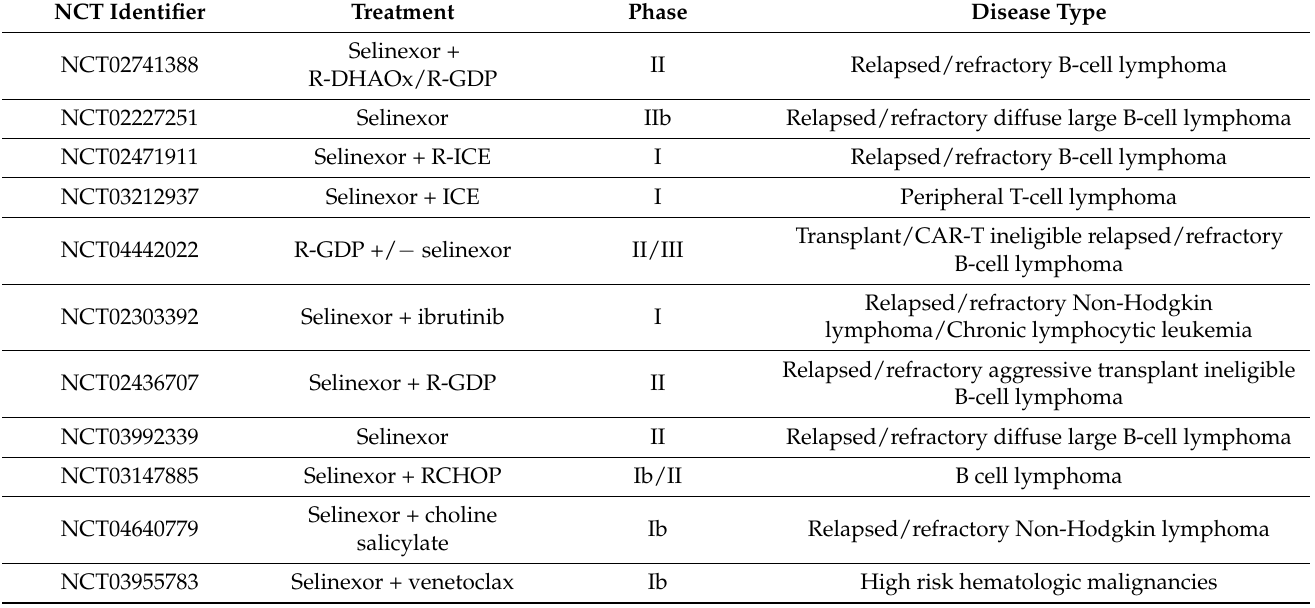
Table 5. Ongoing Clinical Trials for Selinexor Treatment in Non-Hodgkin